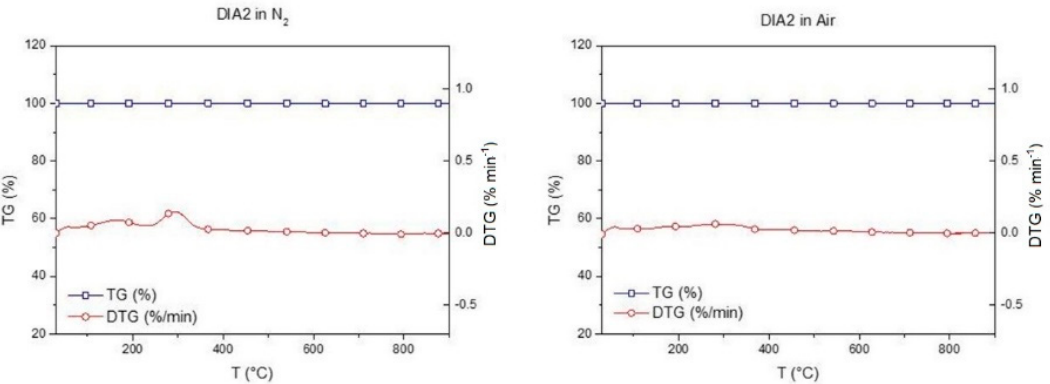
Figure 5. TG/DTG curves of diatomite DIA2 in N 2 and air atmosphere